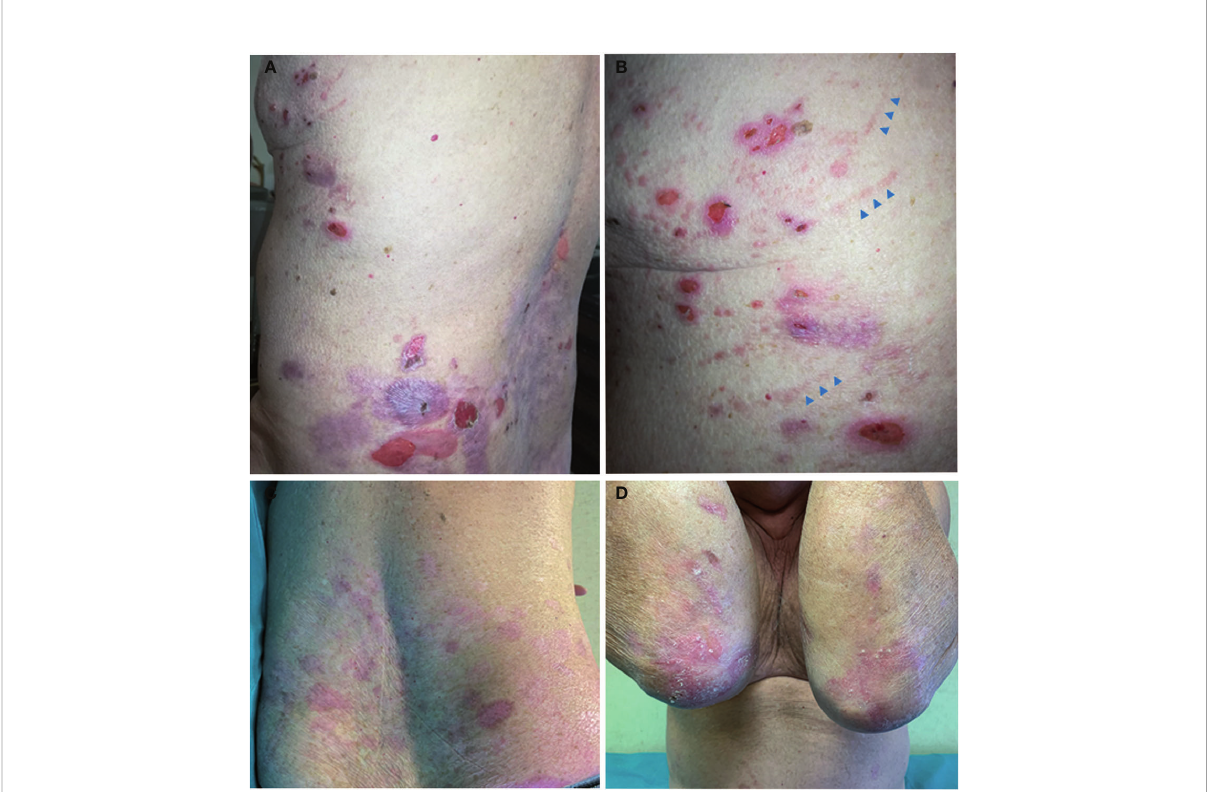
FIGURE 1 Clinical fi ndings. (A, B) Patient clinical presentation at age 68 following disease worsening: blisters, erosions, and crusts with an erythematous halo are scattered on the back and thorax. Note linear erythematous lesions (arrowheads) on the lateral thorax in (B) due to scratching. (C, D) Clinical manifestations at age 69 when the patient was on bullous pemphigoid (BP) remission under minimal corticosteroid therapy. Note the absence of active lesions on the trunk, while skin erosions and atrophic scarring with milia, typical of localized recessive dystrophic epidermolysis bullosa, are visible on